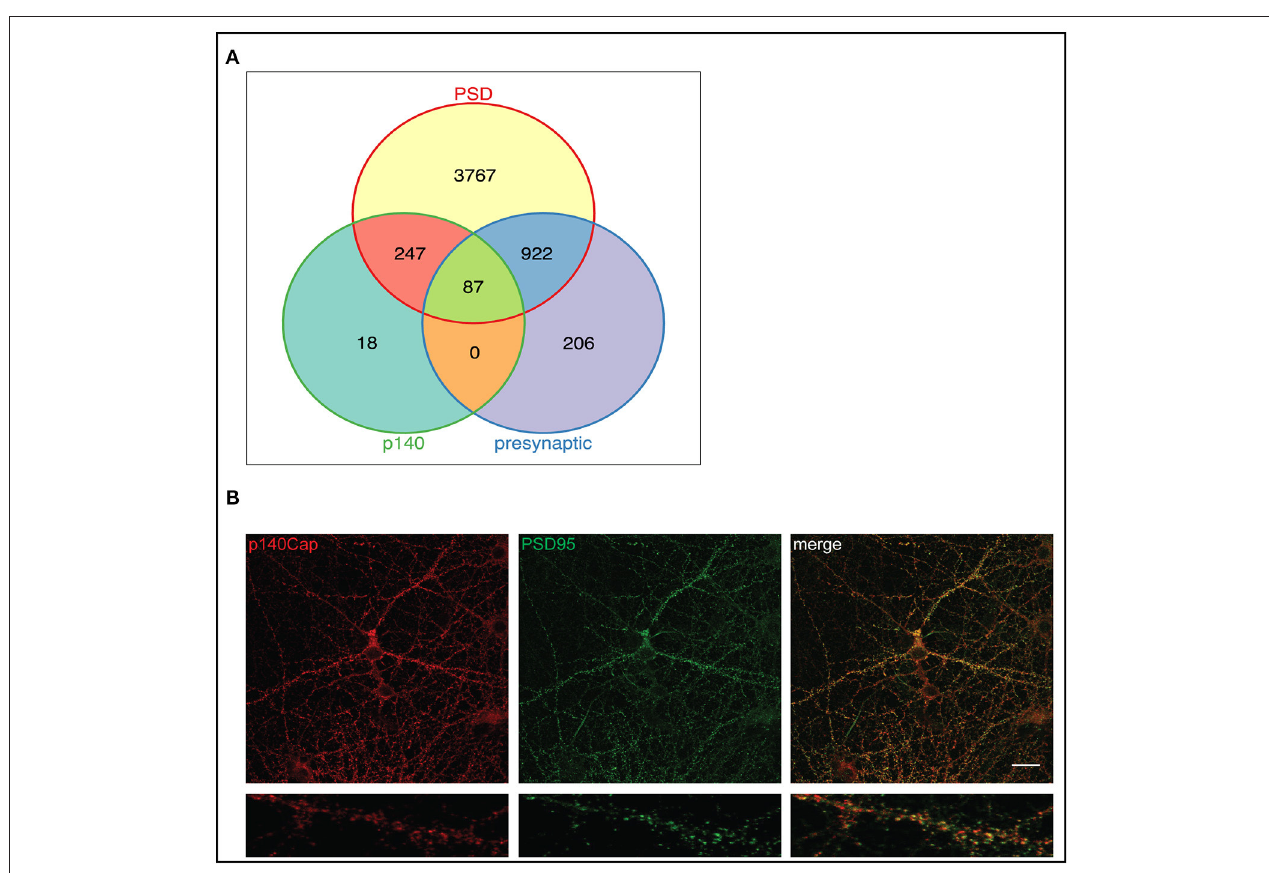
FIGURE 2 | p140Cap interacting proteins distribution in pre- and postsynaptic compartments and functional modules of the p140Cap interactome. (A) Venn diagram showing the overlap of 352 p140Cap interactors (green) mapped in pre- (purple) and postsynaptic (yellow) datasets. (B) p140Cap co-localization with PSD95 on primary hippocampal neurons. DIV 17 hippocampal neurons were stained with antibodies to p140Cap (red) and to PSD95 (green). Merge is shown on the right (Upper panels) Scale bar 20 µ m. Magnification of a segment of dendrite is shown in lower